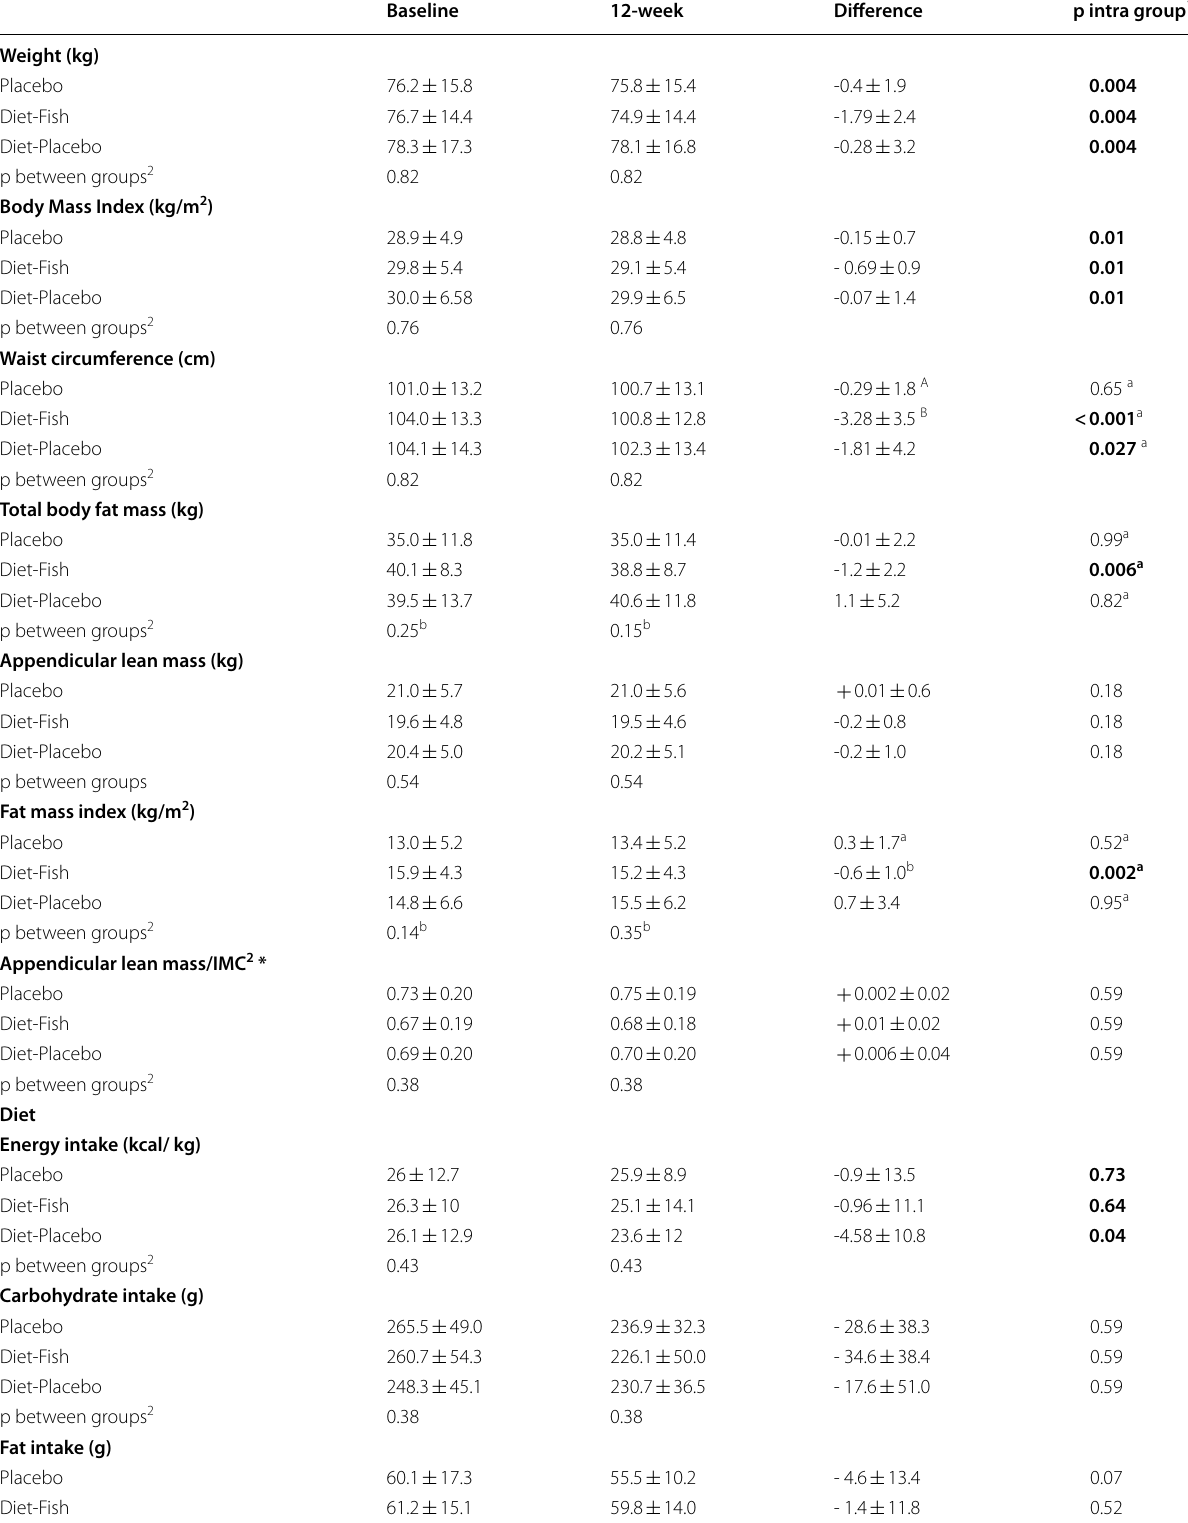
Table 3 Body composition measurements, food intake and physical activity before and after the 12-week nutrition intervention Baseline 12-week Difference p intra group